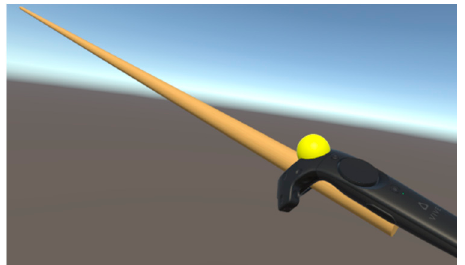
Figure 3. Rod-shaped object with VR controller.